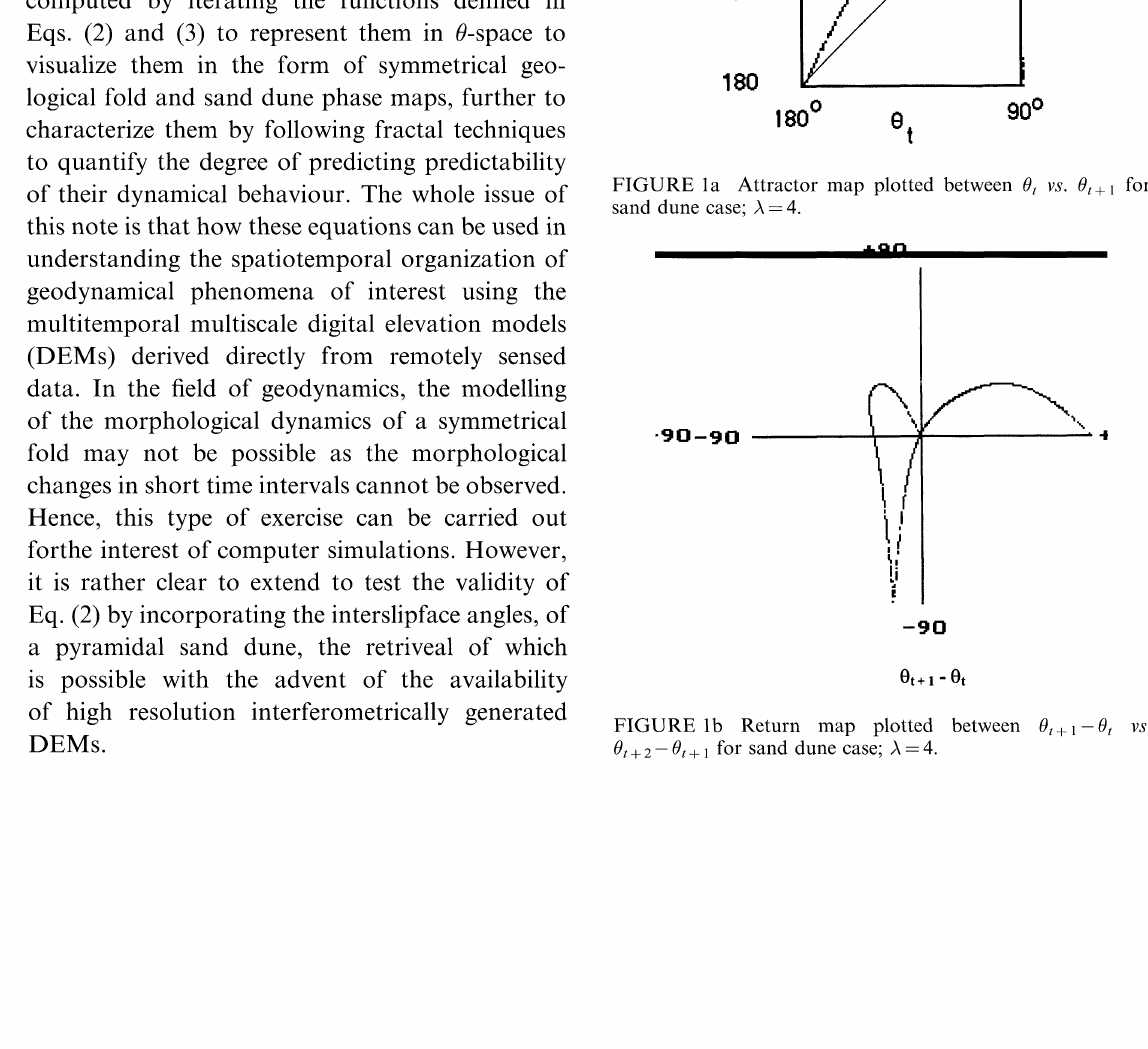
FIGURE lb Return map plotted between Ot+l--O VS. Ot + 0 + for sand dune case; A